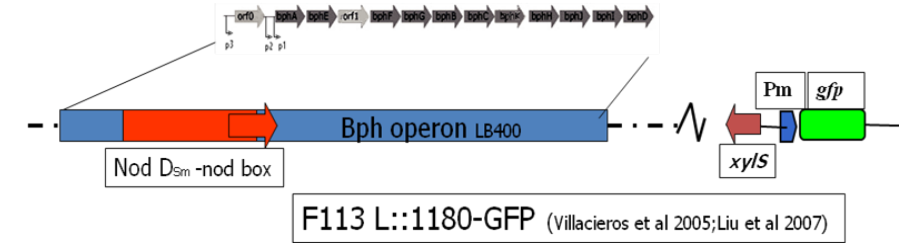
Figure 4. Genetic organization of whole cell rhizosphere biosensor Pseudomonas fluorescens F113L::1180-GFP. This bacterium can utilize biphenyl as a carbon source and biodegrade a range of PCBs. The bph operon originated from the PCB degrader Burkholderia xenovorans LB400 and it is constitutively expressed by the NodD-nod box regulatory unit from the symbiotic bacterium Sinorhizobium meliloti . The XylS-p cassette originated from plasmid pJBA26. The host bacterium P. fluorescens F113 is an active plant root colonizer and biocontrol strain.